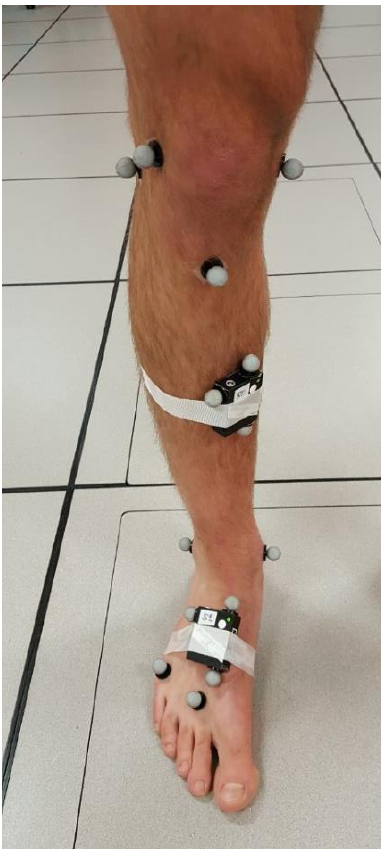
Figure 2. Illustration of the criterion-related validation set-up: Anatomical (applied to bony landmarks) and technical (applied to sensors boxes) markers, as well as the two IMUs, affixed on the right foot (along the second metatarsal) and leg (medial upper shank) of the participant, are represented. Among the anatomical markers, only the second and fifth metatarsal, and calcaneal tuberosity markers were used for this study. No marker was present for the construct validation study.